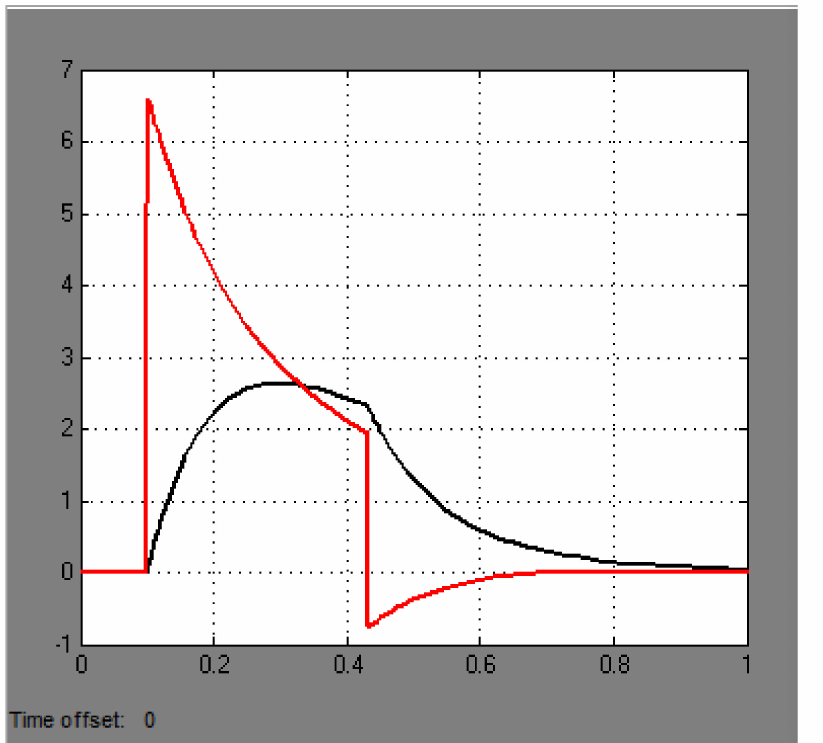
Figure 11. Combined current and velocity graph.